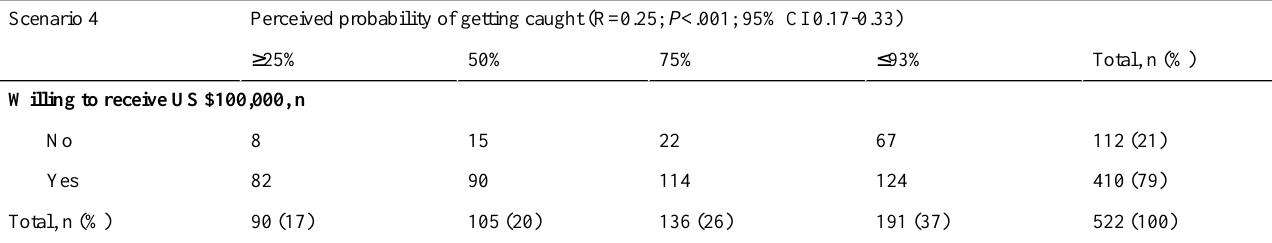
Table 4. Personal context: your mother needs an experimental treatment (scenario